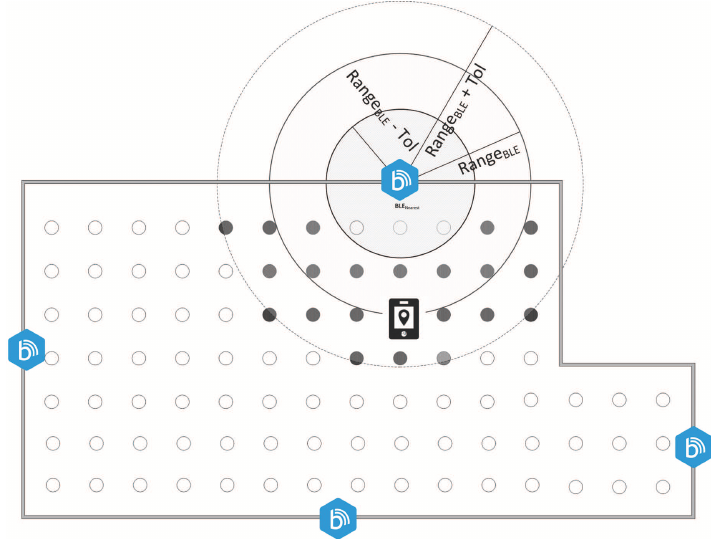
Figure 1. Concept of the proposed i-KNN algorithm: Bluetooth Low Energy (BLE) utilization for Wi-Fi radiomap subset